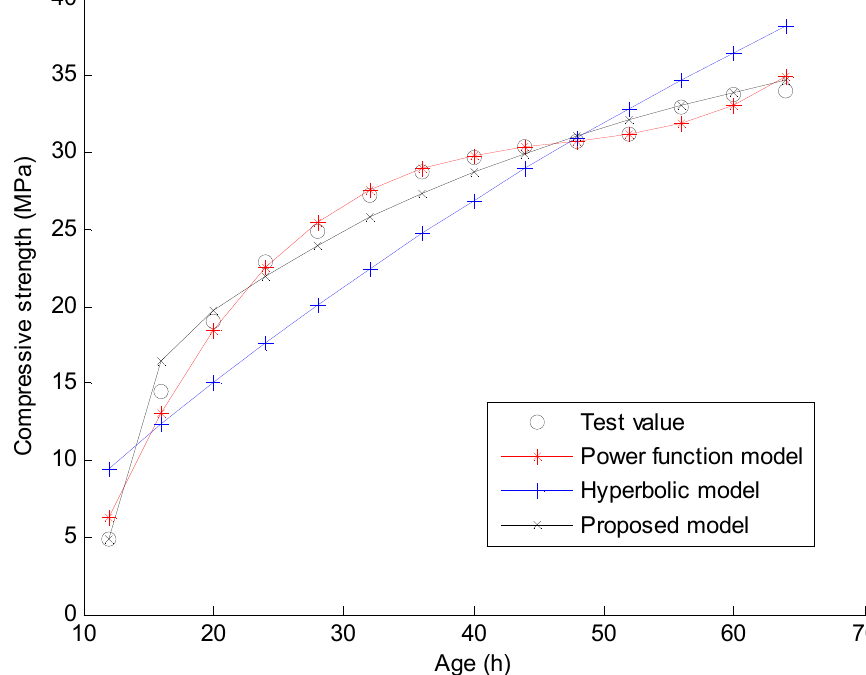
Figure 3. Curve fitting results using the three models for C40 under natural curing.